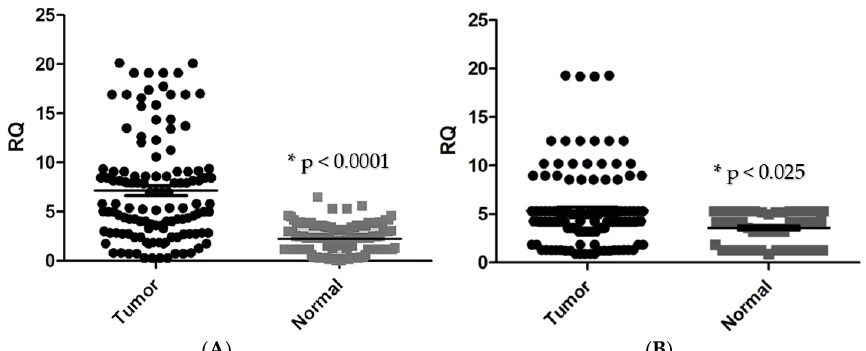
Figure 1. ( A ) Comparison of CTGF mRNA expression in tumour and normal tissues (* p < 0.0001). ( B ) MMP-1 mRNA expression is compared in tumour and normal tissues. (* p < 0.025). * RQ related to relative quantification.